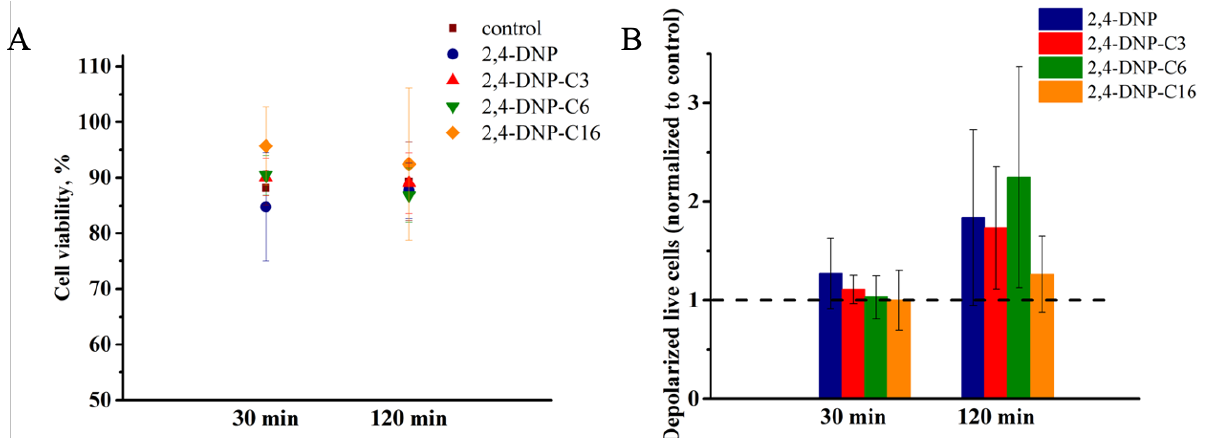
Figure 3. Change in mitochondrial potential after 2,4-DNP (compound 1 ), 2,4-DNP-C16 (compound 2 ), 2,4-DNP-C6 (compound 3 ), 2,4-DNP-C3 (compound 4 ) cell treatments. 4T1-Luc cells were incu- bated with the tested compounds (200 µ M) for 30 min and 120 min in RPMI 1640 (10% FBS) at 37 ◦ C, 5% CO 2 , and then the mitochondrial potential was assessed by a cytofluorimetric technique. Samples with untreated cells were set as control. ( A ) The percentage of living cells after treatments. Data are presented as mean ± StD ( n = 4). ( B ) The percentage of depolarized living cells after treatments, normalized to untreated control. Data are presented as mean ± StD ( n =